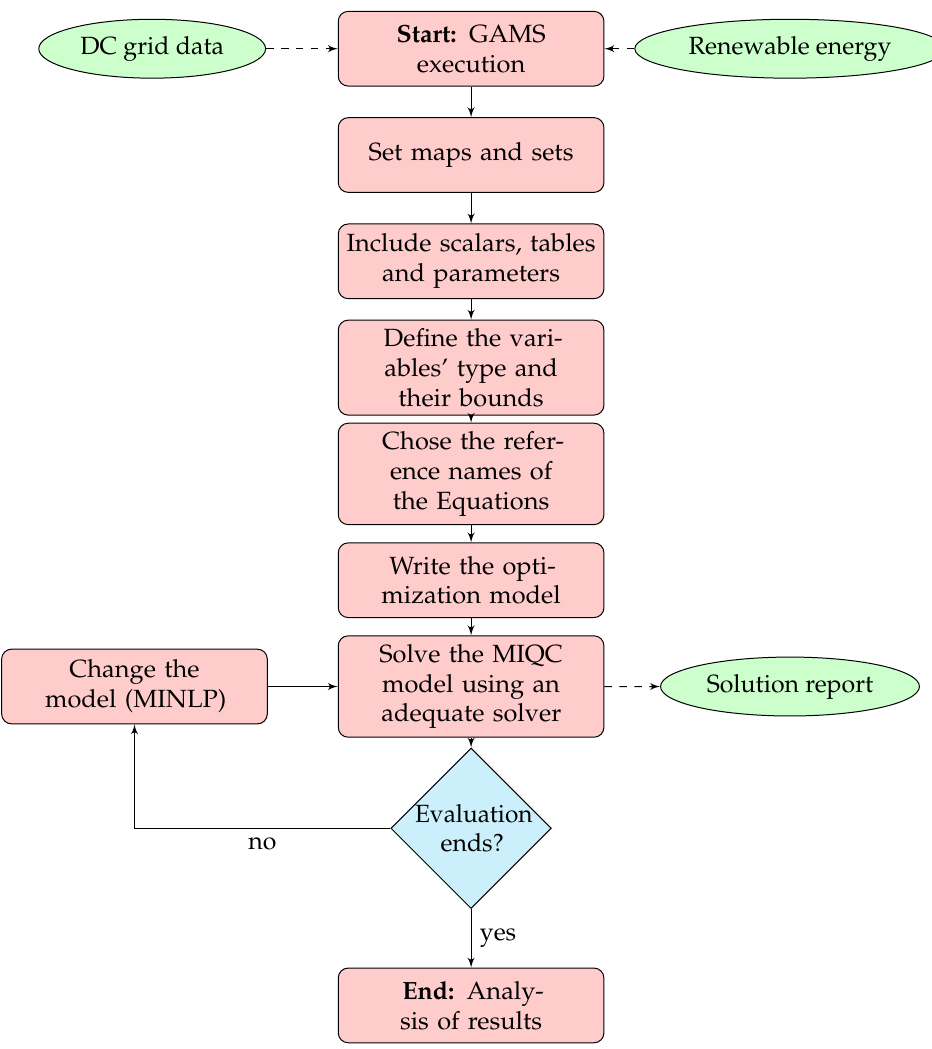
Figure 2. Procedure to solve an optimization model in